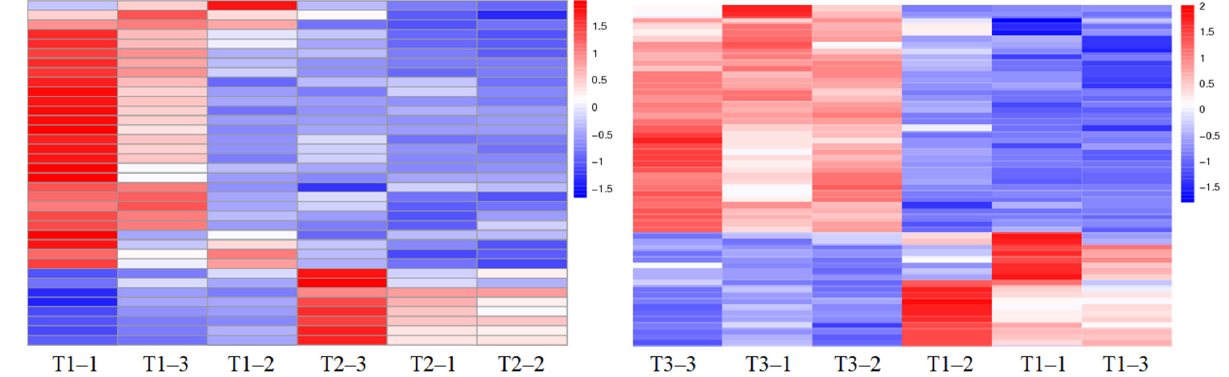
Figure 3. Cluster heat maps of the differentially expressed proteins (DEPs) in T1, T2, and T3 treatments. The values > 0 in the images indicate UR, while the values < 0 indicate DR. The order of the DEPS in the images was shown in Table S1 and S2.